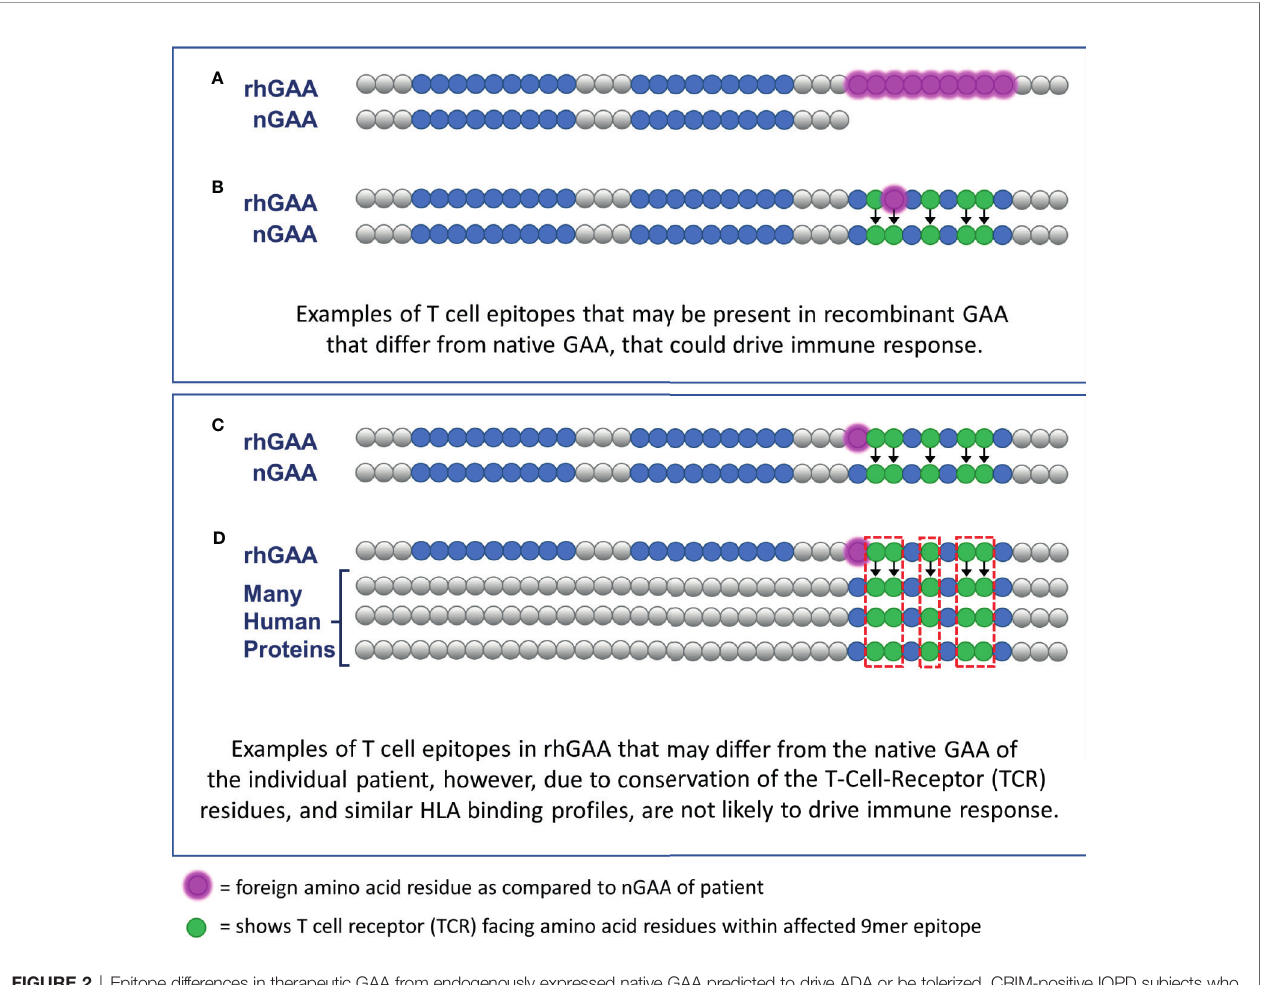
FIGURE 2 | Epitope differences in therapeutic GAA from endogenously expressed native GAA predicted to drive ADA or be tolerized. CRIM-positive IOPD subjects who express residual nGAA may be tolerant to epitopes conserved, for their HLA, with the rhGAA replacement protein. (A) T cell epitopes contained within the rhGAA may be recognized as “ foreign ” if they are within the truncated or mutated portions of the patient-speci fi c nGAA. (B) T cell epitopes within the rhGAA that contain T cell receptor (TCR)-facing residues that are different from those found in nGAA may be suf fi cient to generate a different T cell phenotype response. (C) T cell epitopes within the rhGAA that contains different MHC-facing residues but the same TCR-facing residues as epitopes found in nGAA are predicted to be tolerated by the immune system (this hypothesis was included in PIMA V3). (D) The presence of a T cell epitope in the rhGAA sequence with TCR-facing residues highly cross-conserved with several self- human proteins may not appear as foreign and would also be tolerated by the immune system. (This hypothesis was included in PIMA